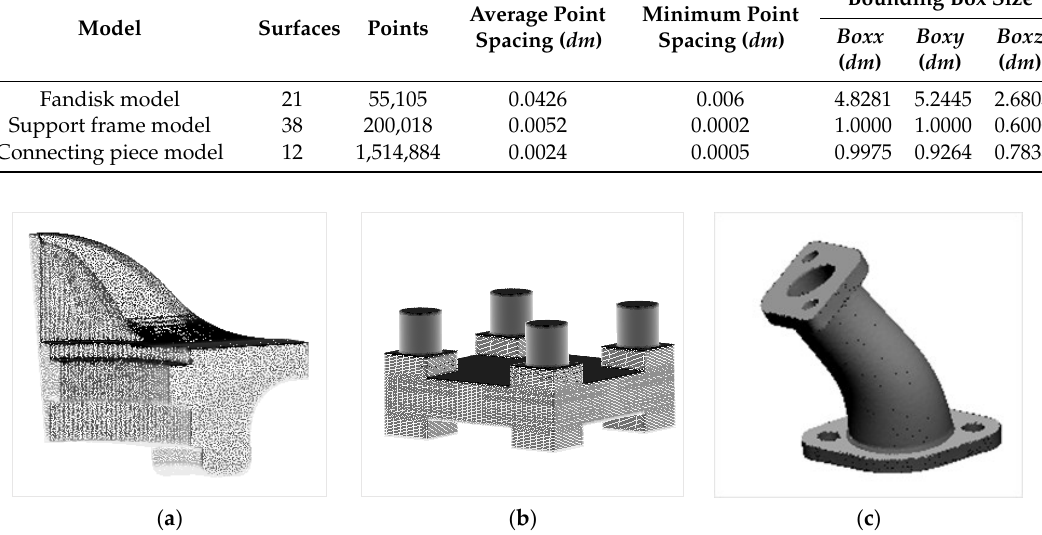
Figure 10. Model display: ( a ) fandisk model; ( b ) support frame model; ( c ) connecting piece model.